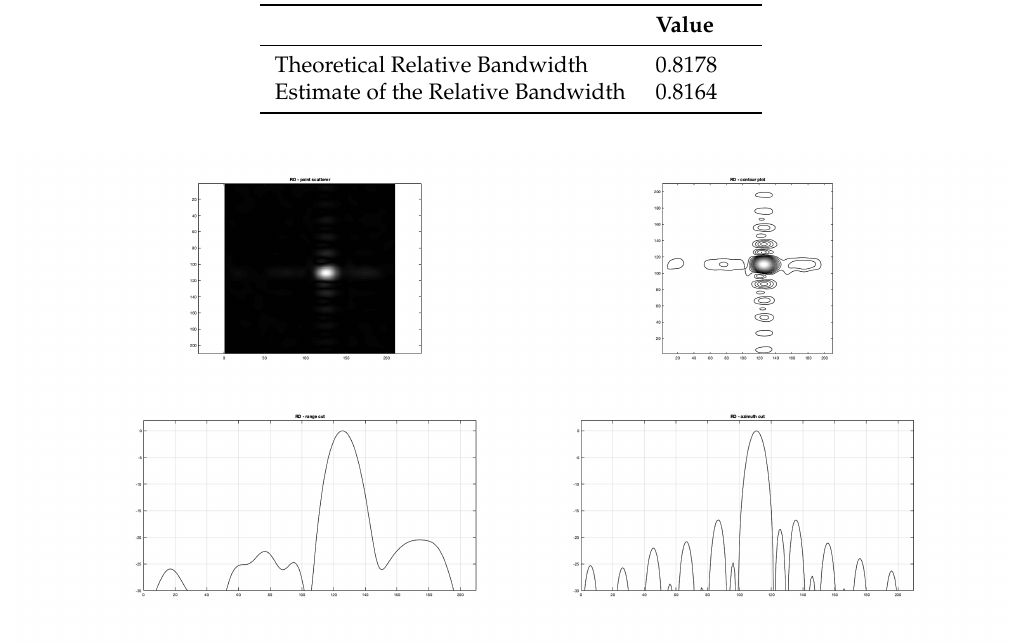
Figure 9. Range Doppler algorithm. Point scatterer image, contour plot, and range and azimuth cuts.